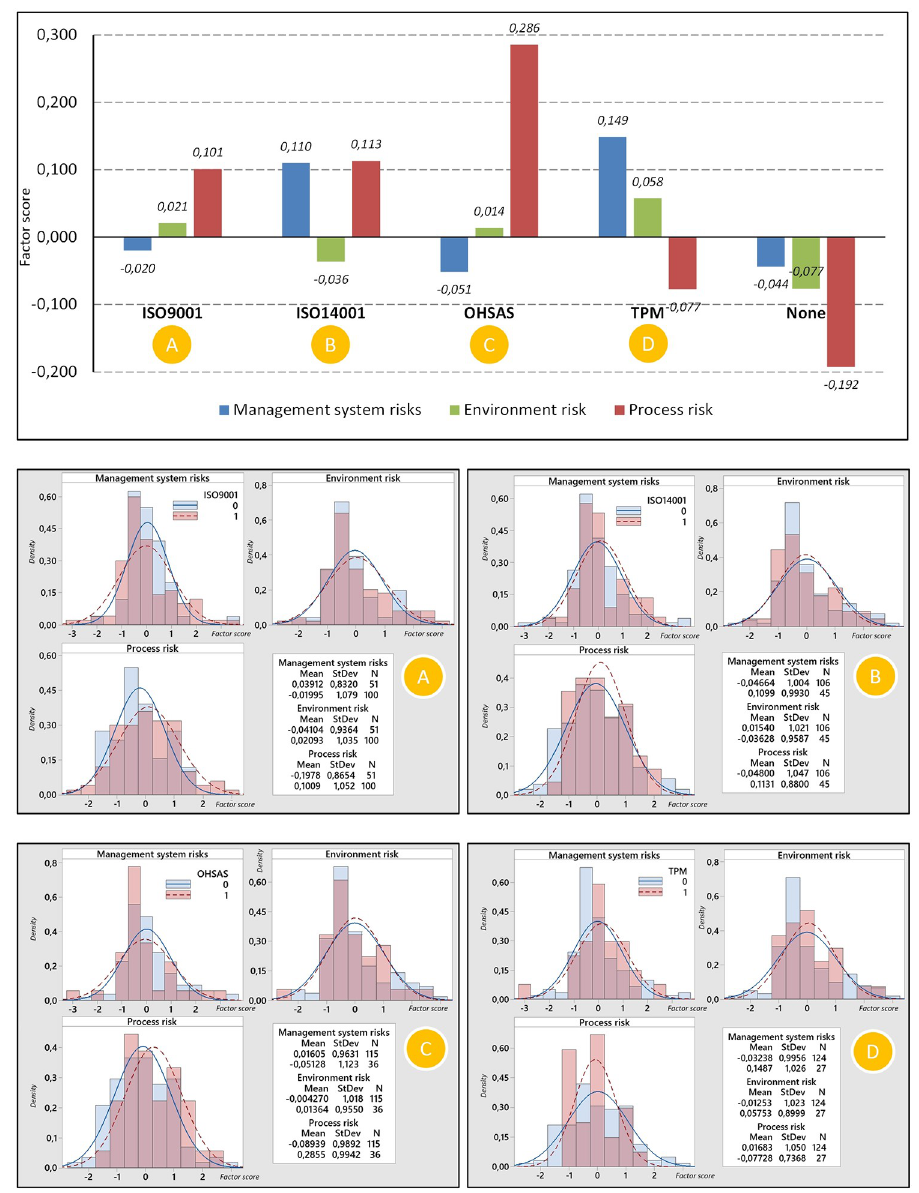
Fig 4. Relationships between particular management systems and three identified meta-factors of